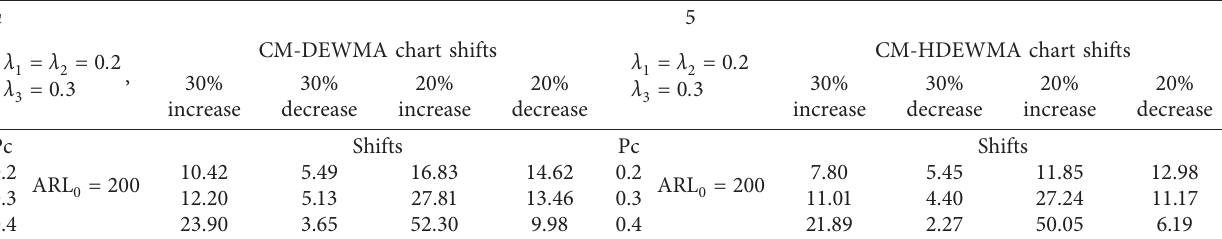
Table 7: Out-of-control ARL values for CM-HDEWMA and CM-DEWMA control charts for n � 5 and α � 1 , β � 1 . 5 n 5 � λ � 0 . 2 λ 1 2 0.2